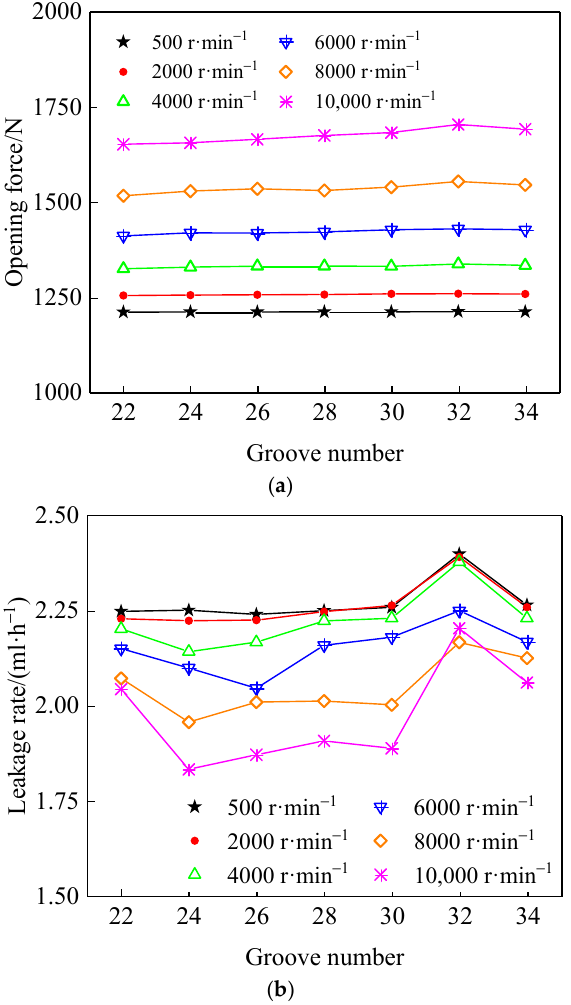
Figure 13. Influence of the groove number on the sealing performance: ( a ) Influence on the opening force; ( b ) Influence on the leakage rate. ( r k = 34 mm, h ki = h g = 50 μ m, r o = 30.6 mm, γ = 0.5, λ = 0.9, α = 30°, Δ p = 0.5 MPa).